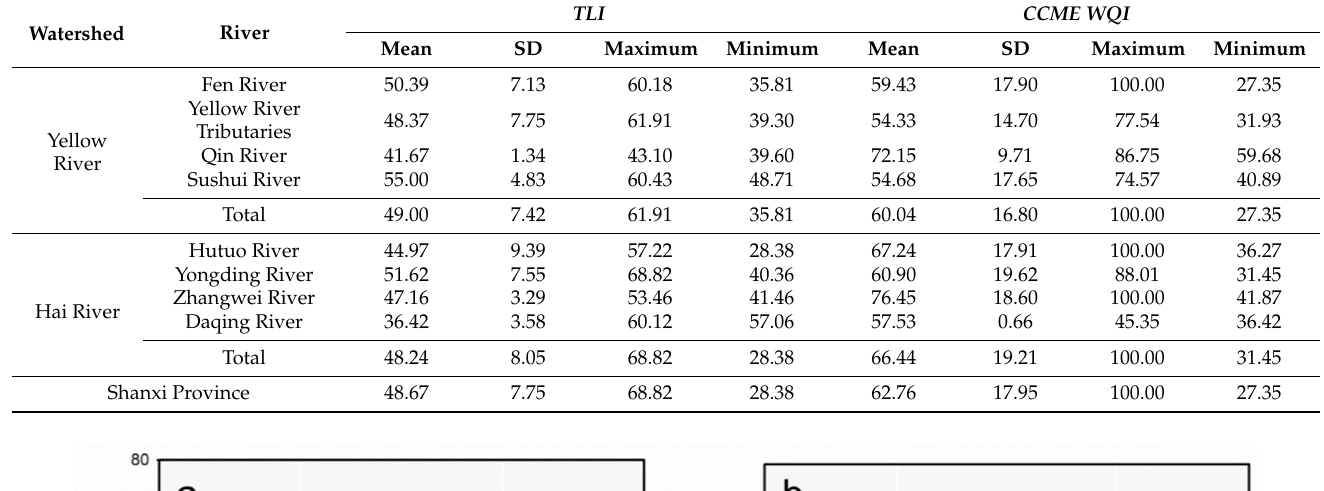
Table 3. Results of the eutrophication state ( TLI ) and water quality ( CCME WQI ) in different watersheds and rivers. Watershed